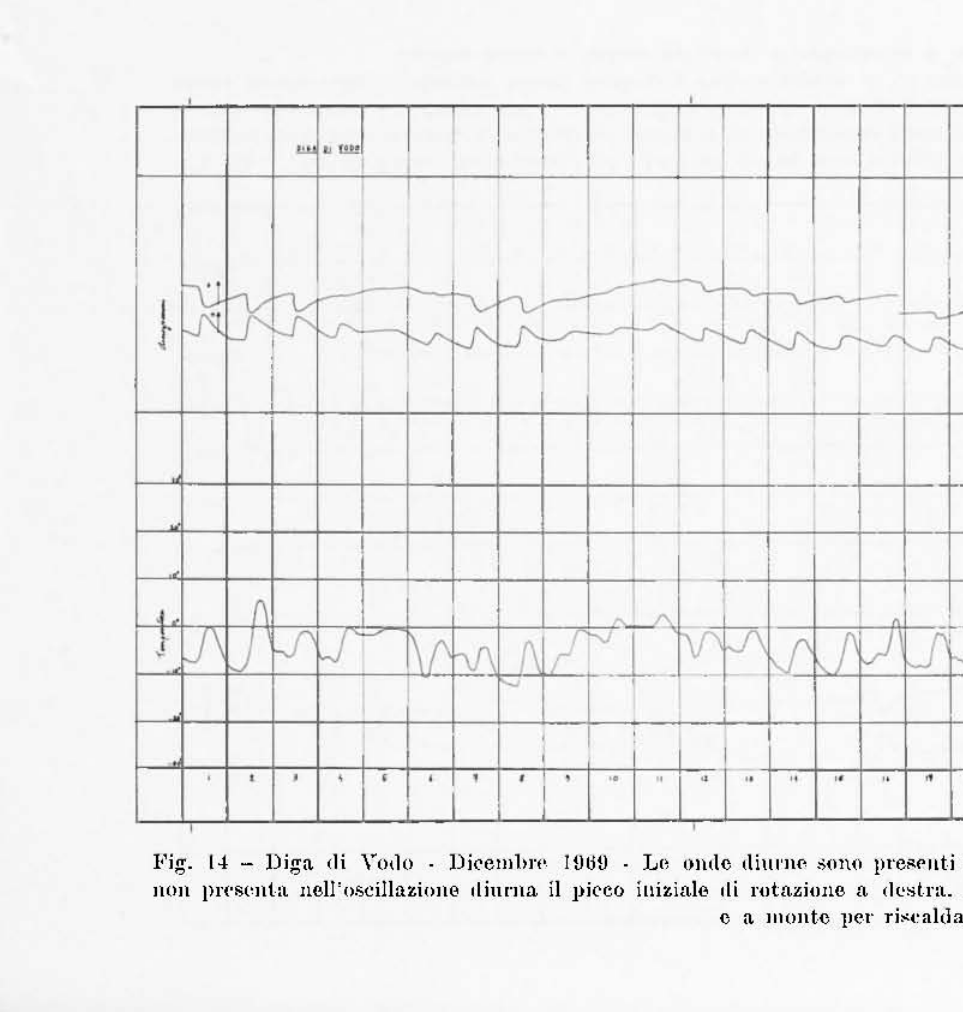
. , • I I Fig. [4 - Diga di YOllo . Dircmhn- [DIHl . Le o]u!e lliul'IW sono pre;<PlLti in !'lItT':lmbe le ~OIlIP()IWllti. Il dinugntllllllH lSinisira'llestra non pn's(.nia nell'oscillazione Iliurn11 il piC'co illiziale Ili rotazione a destra. Le variazioni d"indinazione 11 Illng-o !lpriodo .~()n() a Ilest,m e a lIlonte IleT